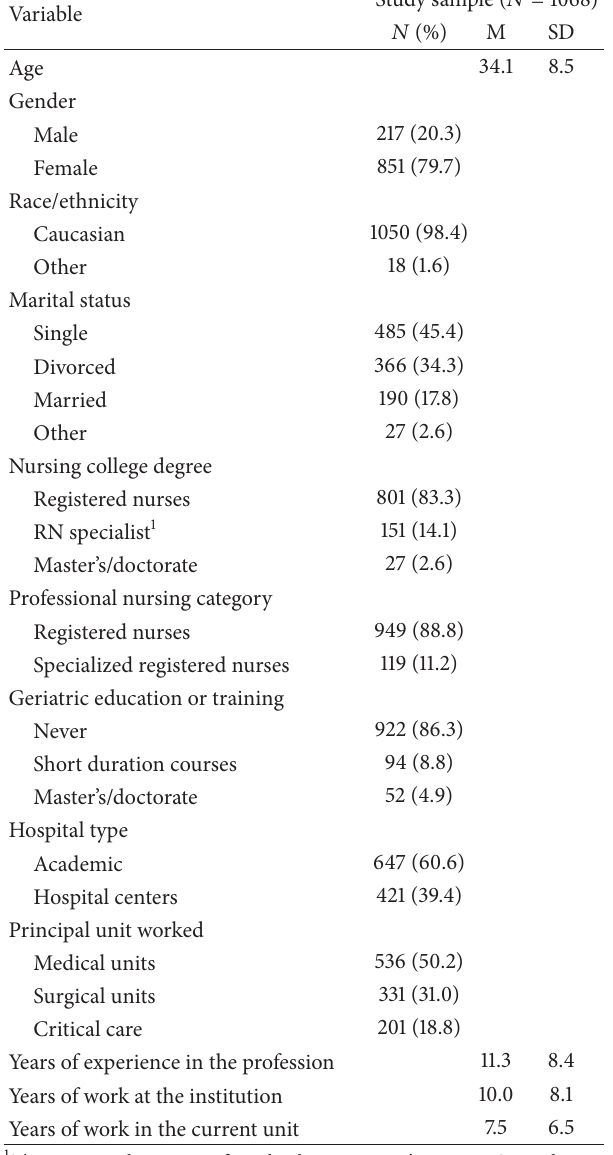
Table 2: Nurse demographics and professional